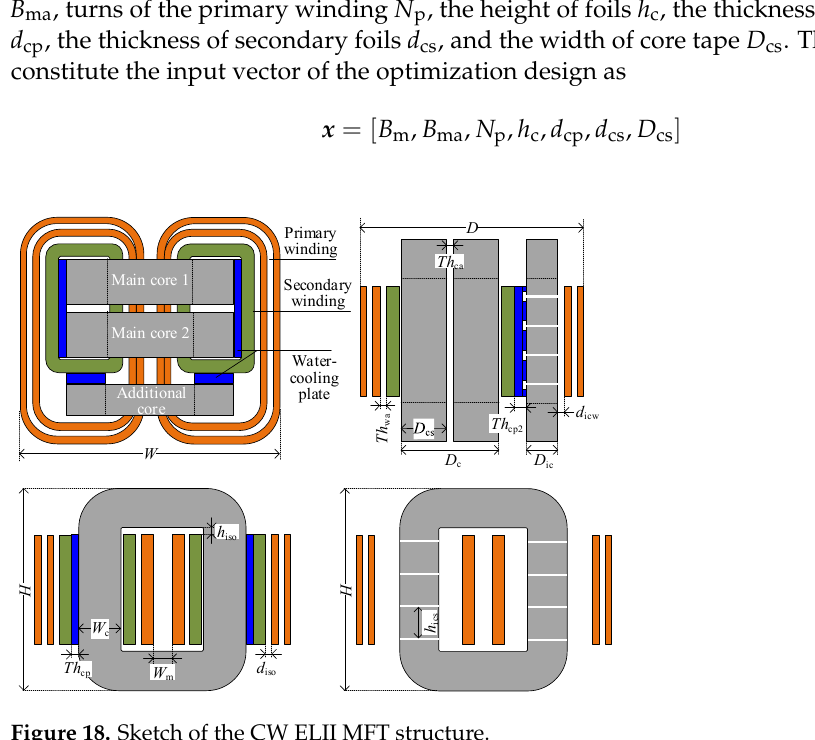
n 8 Figure 17. Thermal network model of the CW ELII MFT. 5. Optimal Design, Analysis, and Example The MFT design is a non-linear, non-convex, and non-continuous problem. The op-